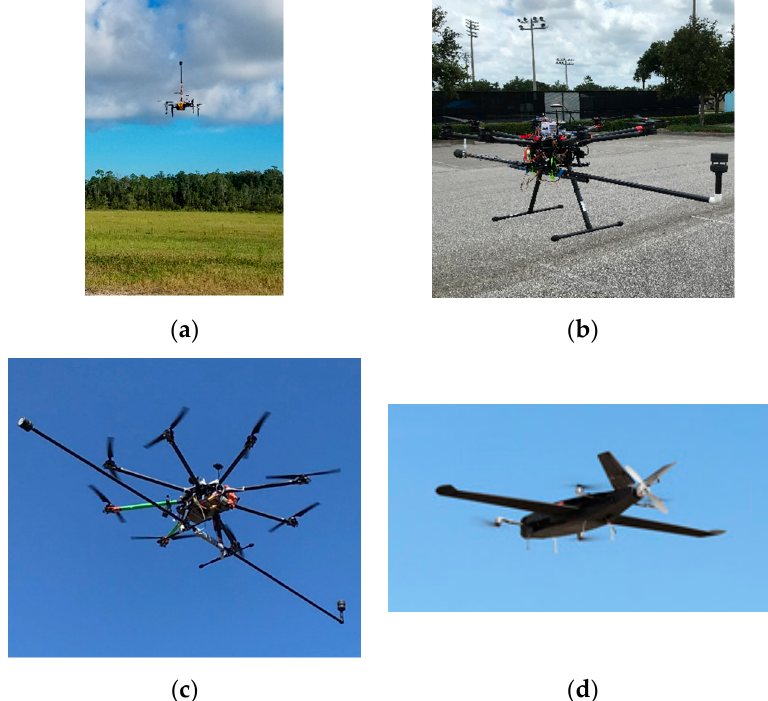
Figure 3. In clockwise order. ( a ) Instrumented multirotor with thermodynamic sensors and a single vertically mounted anemometer; ( b ) instrumented DJI S1000 multirotor with orthogonally mounted anemometers on lateral booms; ( c ) instrumented Tarot T-18 multirotor with orthogonally mounted anemometers on lateral booms; ( d ) instrumented transition fixed-wing unmanned aircraft.